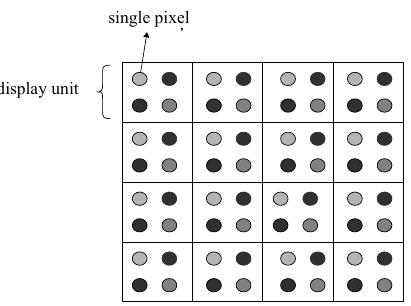
Figure 1. Spatial frequency corresponding to hardcopy image grayscale.